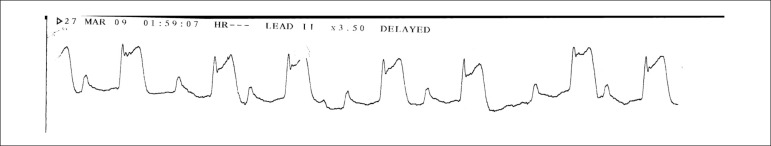
ECG (monitor strip, lead II): presence of a large ST segment elevation with a
positive T wave. Suggestive of acute myocardial infarction.